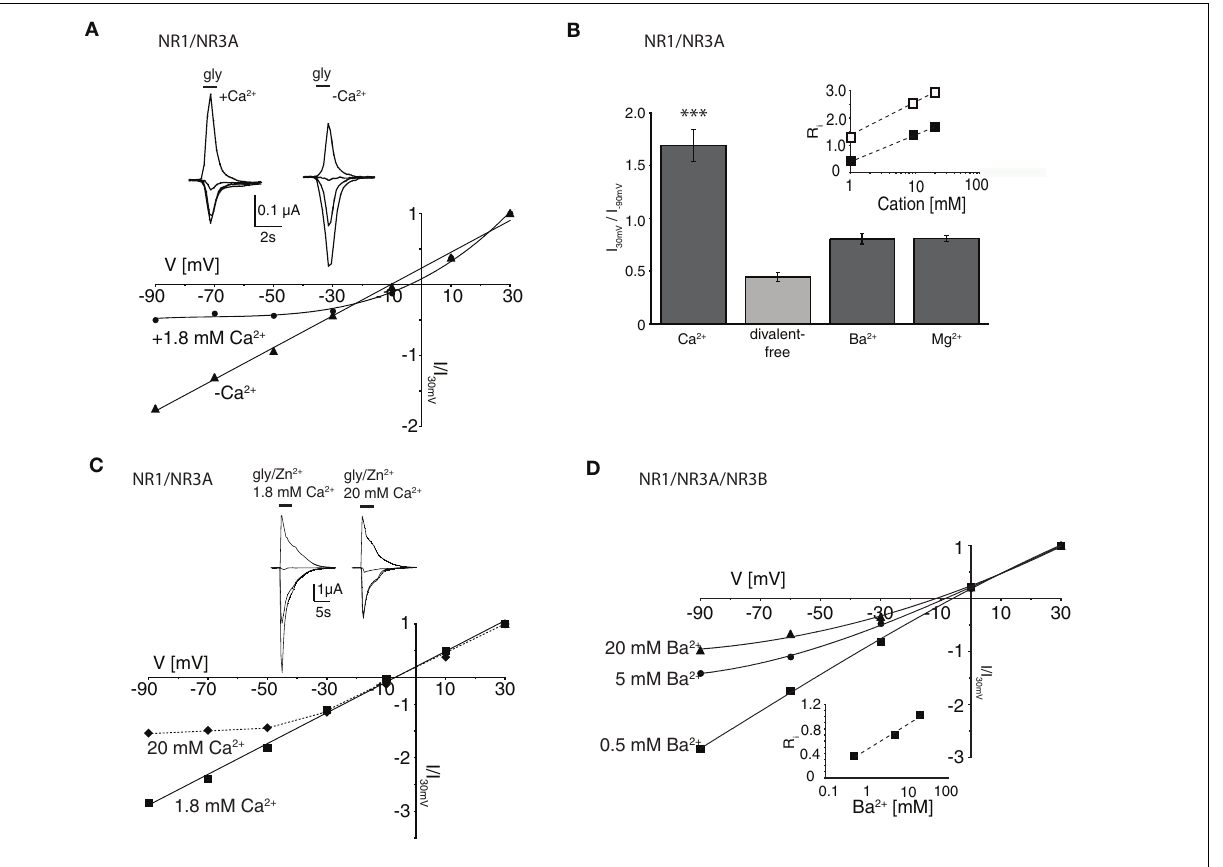
FIGURE 3 | Dependency of I–V relationship on divalent cations for potentiated glycine-activated currents of NR1/NR3A receptors. Normalized I–V glycine-activated NR1/NR3A receptors. (A) Normalized I–V plot of NR1/ plot of potentiated NR1/NR3A receptor currents activated by a saturating NR3A receptor currents activated by a saturating glycine concentration in the glycine concentration and 50 µM Zn 2 + in the presence of 1.8 mM (square) and absence (triangle) and presence (square) of 1.8 mM Ca 2 + . Note, that application 20 mM (triangle) Ca 2 + . Note that an increase of the extracellular Ca 2 + of a saturating glycine concentration (100 µM) in the absence of any divalent concentration from 1.8 to 20 mM led to an outwardly rectifying I-V-relationship cations results in a linear I–V relationship, whereas 1.8 mM Ca 2 + causes an similar to those found under non-potentiated conditions in the presence of low inward current block (see also Figure 1C ). Sample traces are shown above the Ca 2 + . Sample traces are shown above the I–V plot. (D) Increasing divalent I–V plot. (B) Quantifi cation of divalent-dependent inward current block of NR1/ cation concentrations lead to outwardly rectifying I-V relationships in NR3B NR3A receptors. Rectifi cation indices ( R ) of I–V relationships of NR1/NR3A containing NR1/NR3 receptors. Normalized I–V plot of NR1/NR3A/NR3B i receptors in the absence of divalent cations and in the presence of 1.8 mM receptor currents activated by a saturating glycine concentration in the Ca 2 + , Ba 2 + and Mg 2 + are shown. Inset shows a plot of the three different presence of 0.5 mM (square), 5 mM (circle) and 20 mM Ba 2 + (triangle). Inset rectifi cation indices ( R ) fi tted against the respective log of (Ca 2 + ) (open symbol) shows a plot of the three different rectifi cation indices ( R ) fi tted against the i i and (Mg 2 + ) (closed symbol). (C) Effect of different Ca 2 + concentrations on Zn 2 + respective log [Ba 2 +